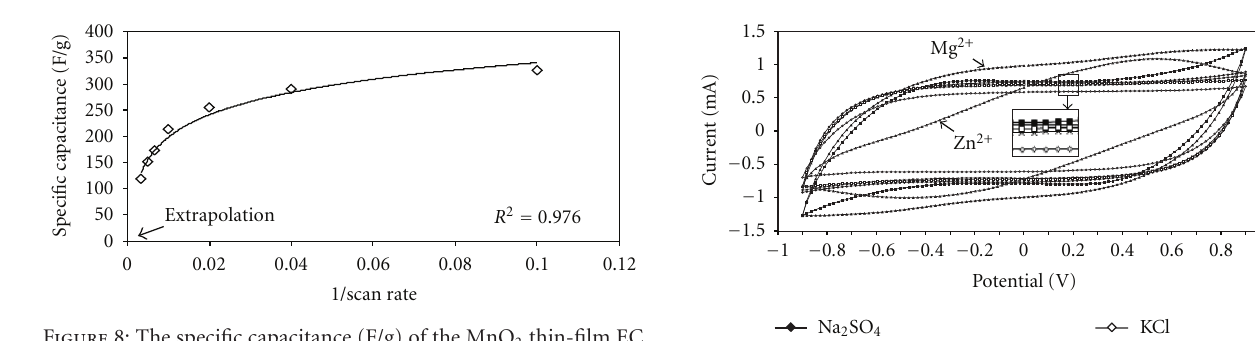
Figure 8: The specific capacitance (F/g) of the MnO 2 thin-film EC prototypes versus the inverse of scan rate (1/scan rate).